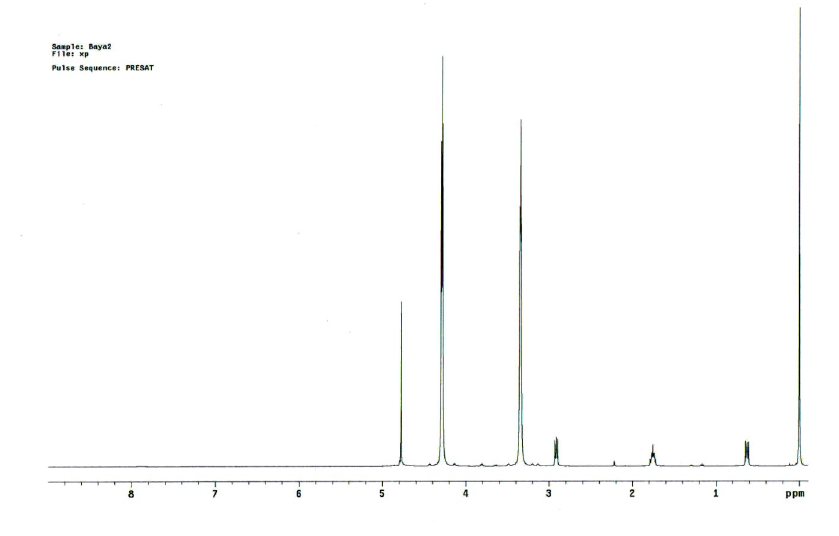
Fig. 1. 1 H NMR spectrum of 2-aminoethyl